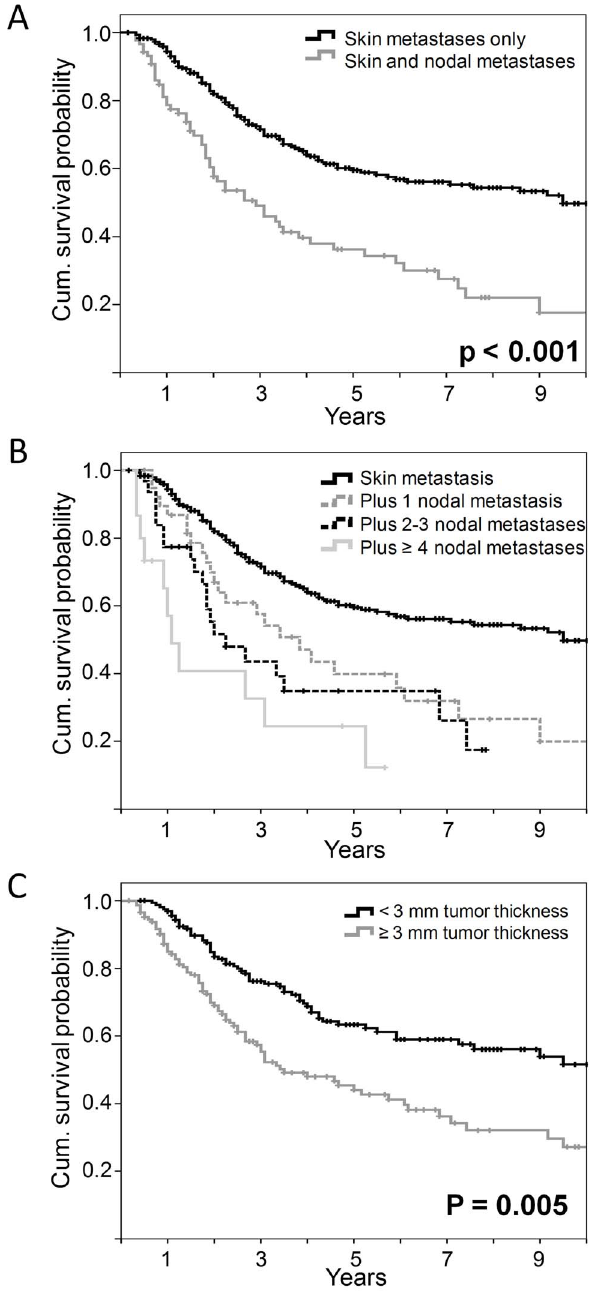
Figure 1. Overall survival of patients with loco-regional skin metastases at the initial diagnosis of metastatic spread. Cumulative survival probabilities are stratified by the presence or absence of additional lymph node metastases (A), the number of additional lymph node metastases (B), or the thickness of the primary melanoma (C) estimated using Kaplan Meier survival analysis. Censored events are indicated by vertical lines. doi:10.1371/journal.pone.0063137.g001 prise the majority of stage III melanoma patients with skin